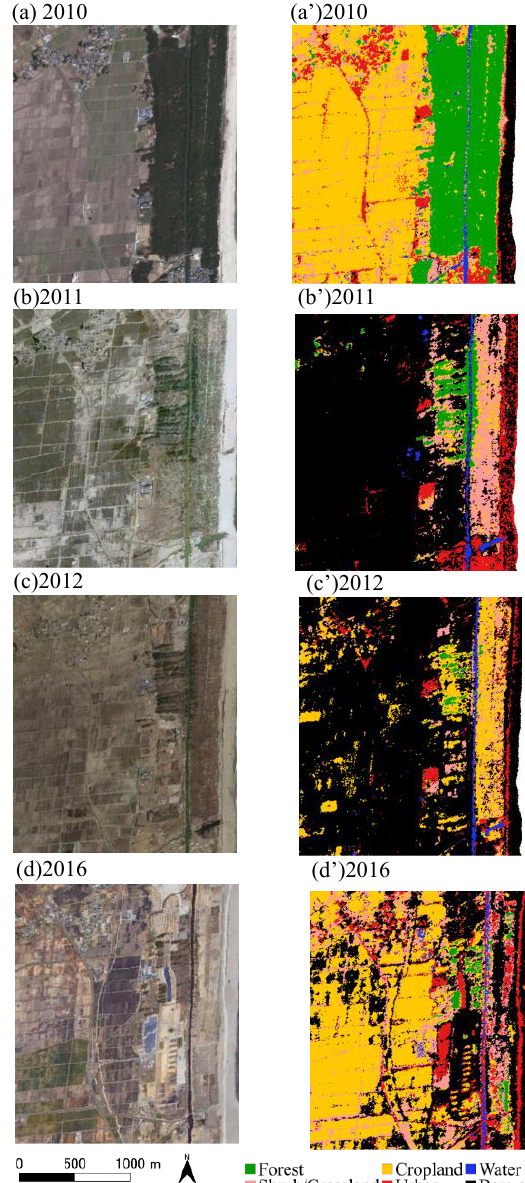
Figure 5. Detailed map of isolated pixels produced by MCS aggregation: (a) to (d) are Google Earth images. (a’) to (d’) are landcover